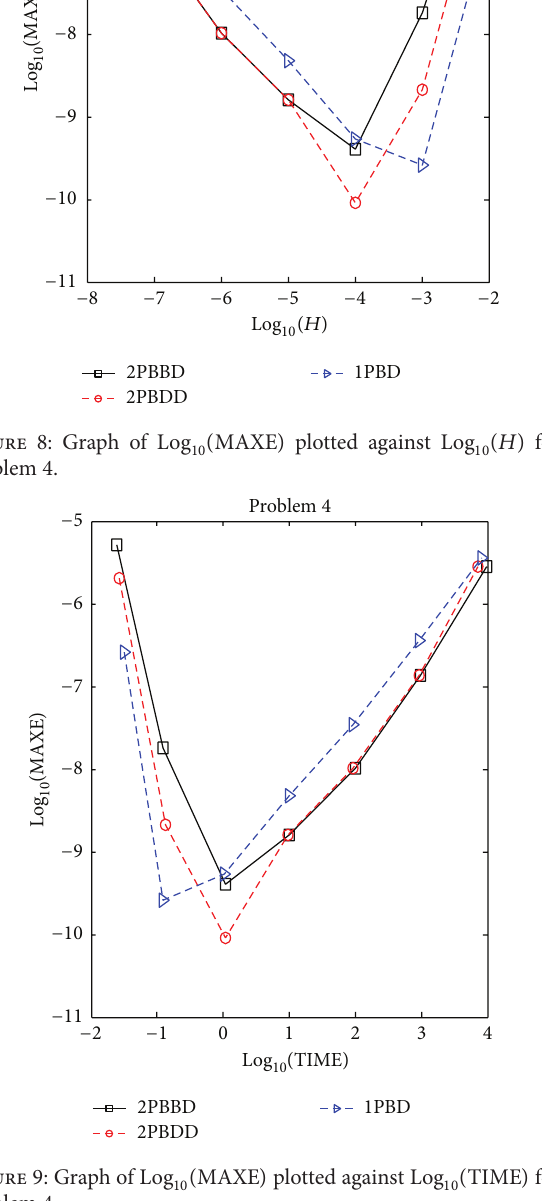
Figure 11: Graph of Log 10 ( MAXE ) plotted against Log 10 ( TIME ) for Problem